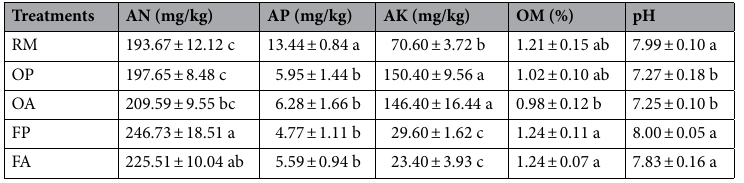
Table 1. Soil properties in different rice systems and areas. Different letters within columns indicate significant differences at P < 0.05.